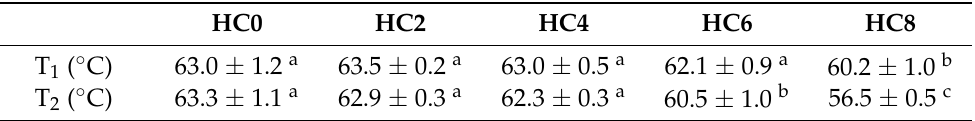
Table 1. Gel formation temperatures of the first (T 1 ) and second (T 2 ) temperature sweeps of HPMC/CL